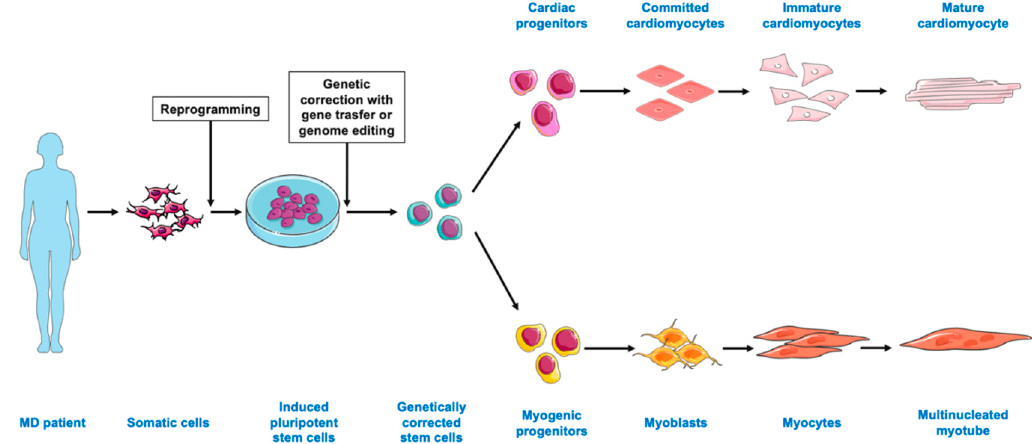
Figure 2. iPSC applications for muscular dystrophies (MDs). Somatic cells obtained from the peripheral blood or skin